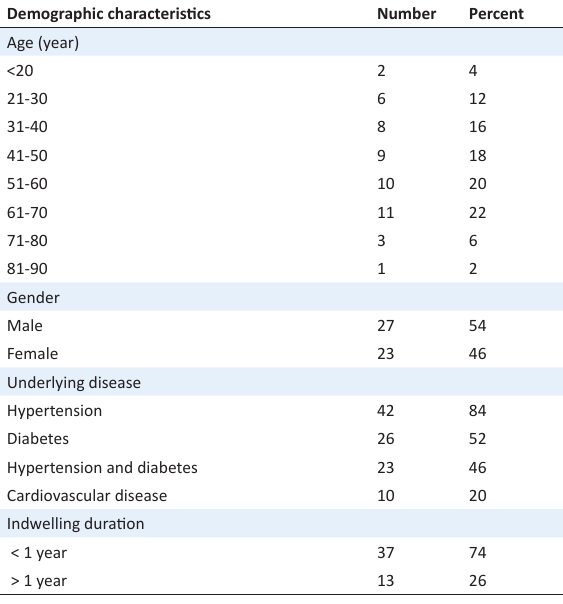
Table 1. Age distribution and underlying diseases in dialysis patients diagnosed with central catheter related infection Demographic